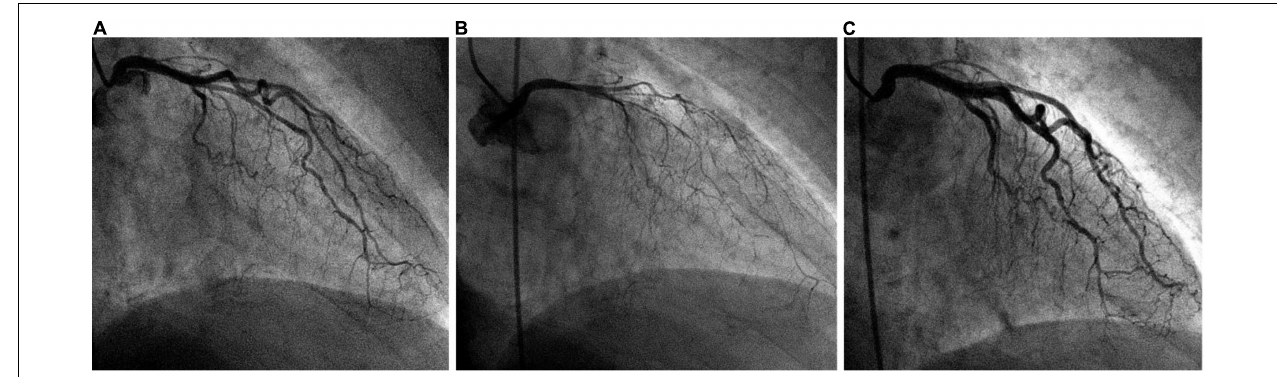
FIGURE 6 | Typical angiographic imaging of the coronary arteries in a patient with a dobutamine-related 4 mm ST-elevation acute ischemic event. (A) At baseline, mild diffuse narrowing of all left coronary artery branches was observed. (B) After intracoronary acetylcholine infusion, severe and diffuse narrowing appeared, with almost total occlusion of all left coronary artery branches (with chest pain, electrocardiogram changes, and recurrent cardiomyopathy on echocardiography; not shown). (C) Immediately after intracoronary nitroglycerin administration, the spasm was relieved. We concluded that coronary endothelial dysfunction was present at baseline and that spasm was stimulated by initial dobutamine testing (outside our hospital) as well as after acetylcholine testing.